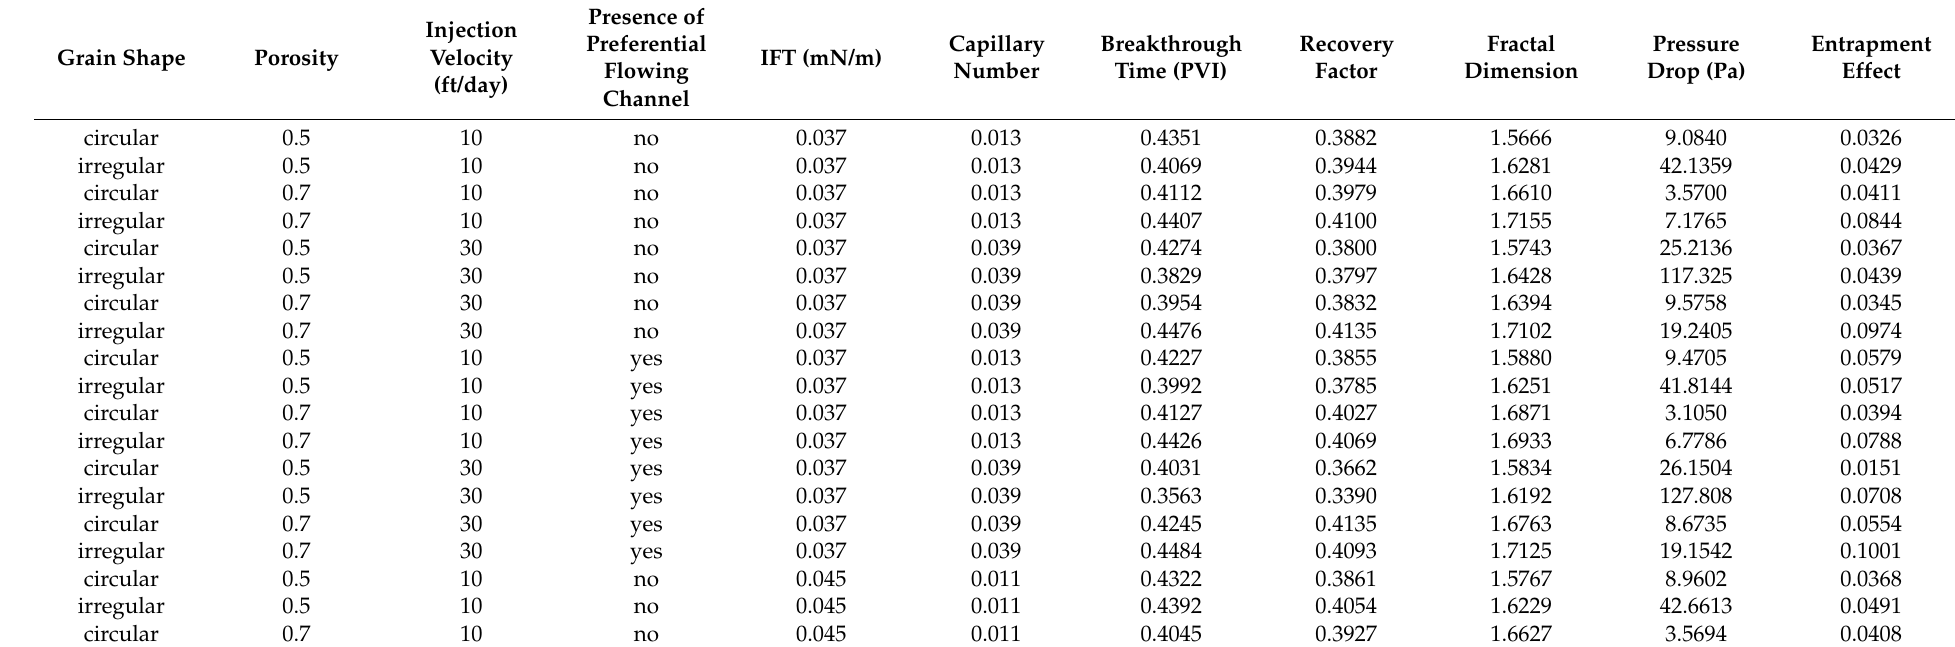
Table 2. The 2 5 factorial experimental design analysis along with the CFD simulation